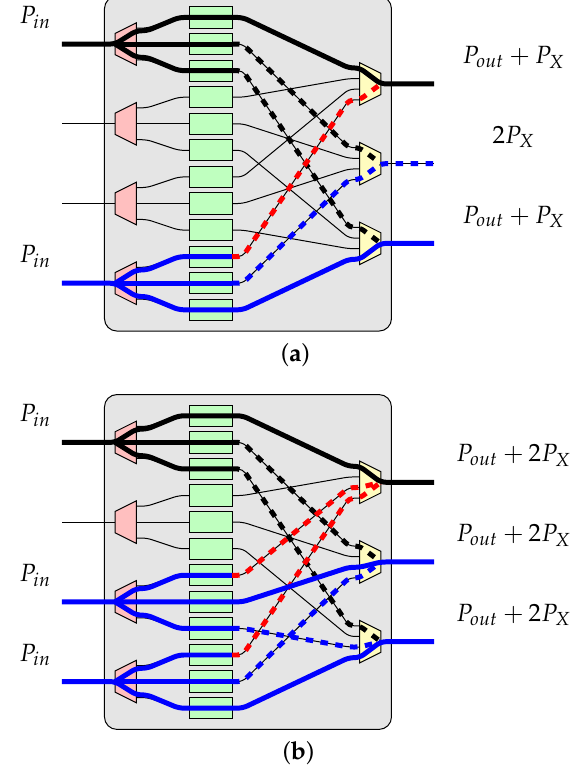
Figure 9. The optical crosstalk (dashed) in the OSE of size 4 × 3. ( a ) with the considered connection (solid black) and one intersecting connection (solid blue); ( b ) with the considered connection (solid black) and two intersecting connections (solid